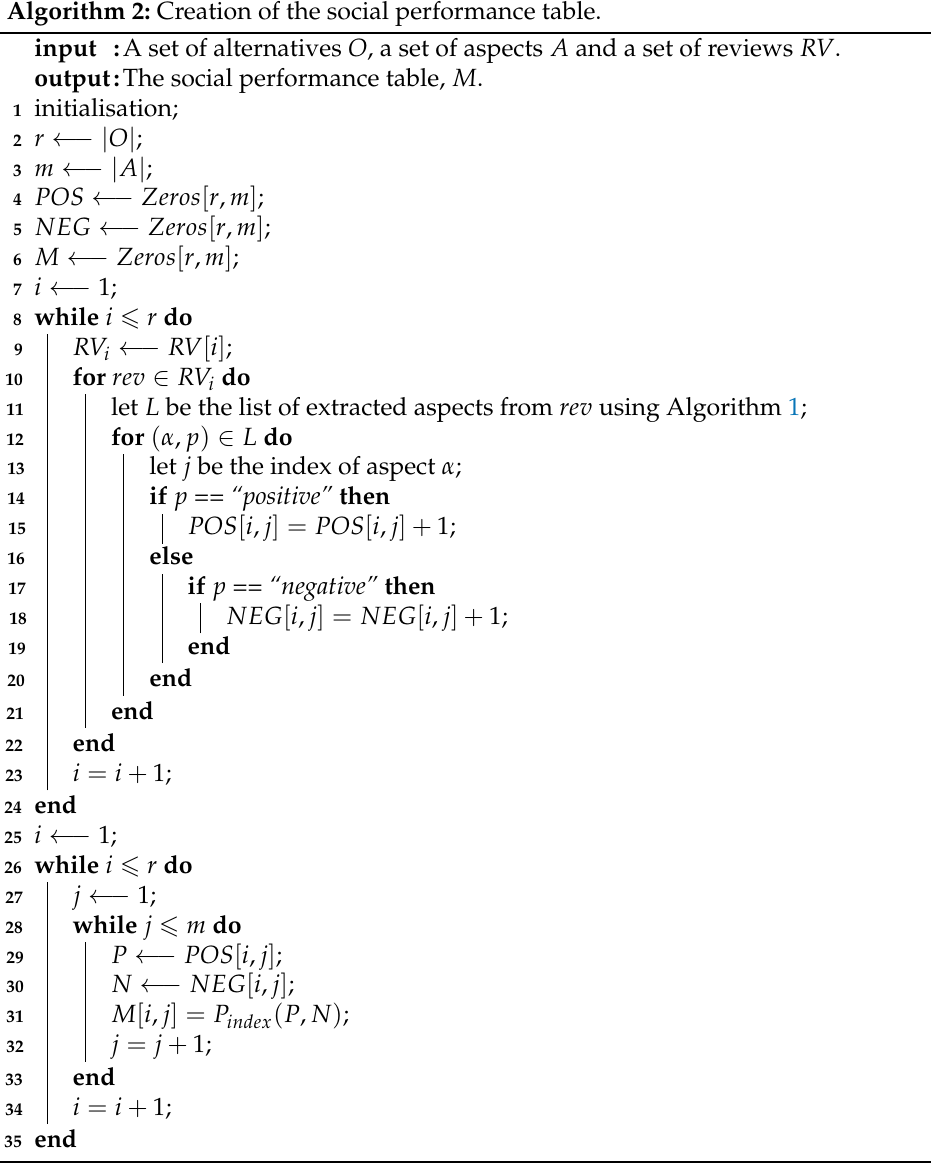
Algorithm 2: Creation of the social performance